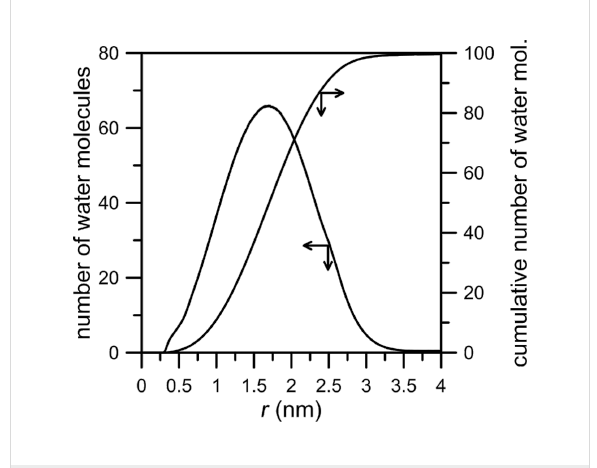
Figure 4: The average number of water molecules as a function of the distance of O w atoms from the center of the rim of an HH nanopore calculated for a CH 4 + N 2 gaseous mixture containing 200 water molecules. The “cumulative number of water molecules” means the average number of particles within a distance r , whereas the “number of molecules” is the non-normalized radial distribution function (RDF), e.g., the RDF without dividing the probability density by the average density in the whole box. The bin width is 0.002 nm.